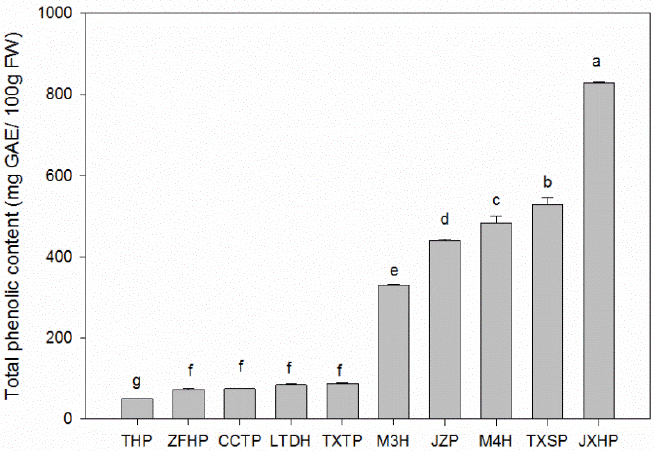
Figure 2. Total phenolic contents of five sweet and five sour wampee varieties. Bars with no letters in common are significantly different ( p < 0.05).